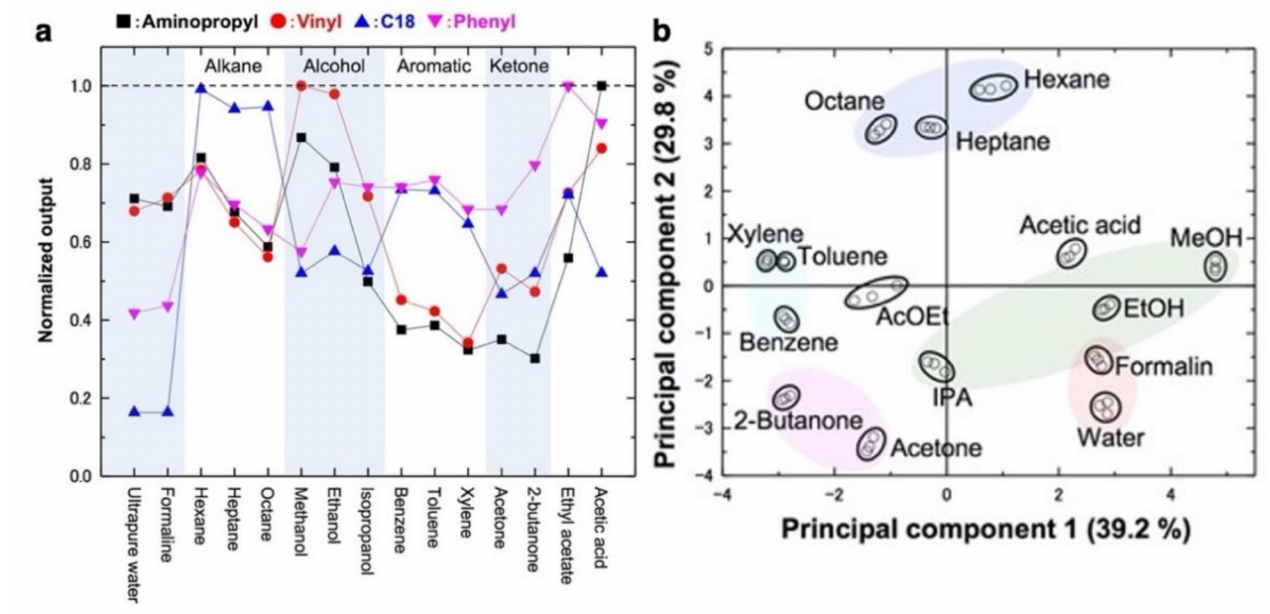
Figure 10. Wide varieties of chemical selectivity obtained from the surface functionalized silica-titania hybrid nanoparticles (STNPs). ( a ) Affinity trend of four different types of STNPs. ( b ) PCA scatter plot of 15 different chemicals shown in ( a ) by using the extracted features from four STNPs bearing different surface functionalities. Reprinted from Ref. [8], the authors licensed under CC-BY